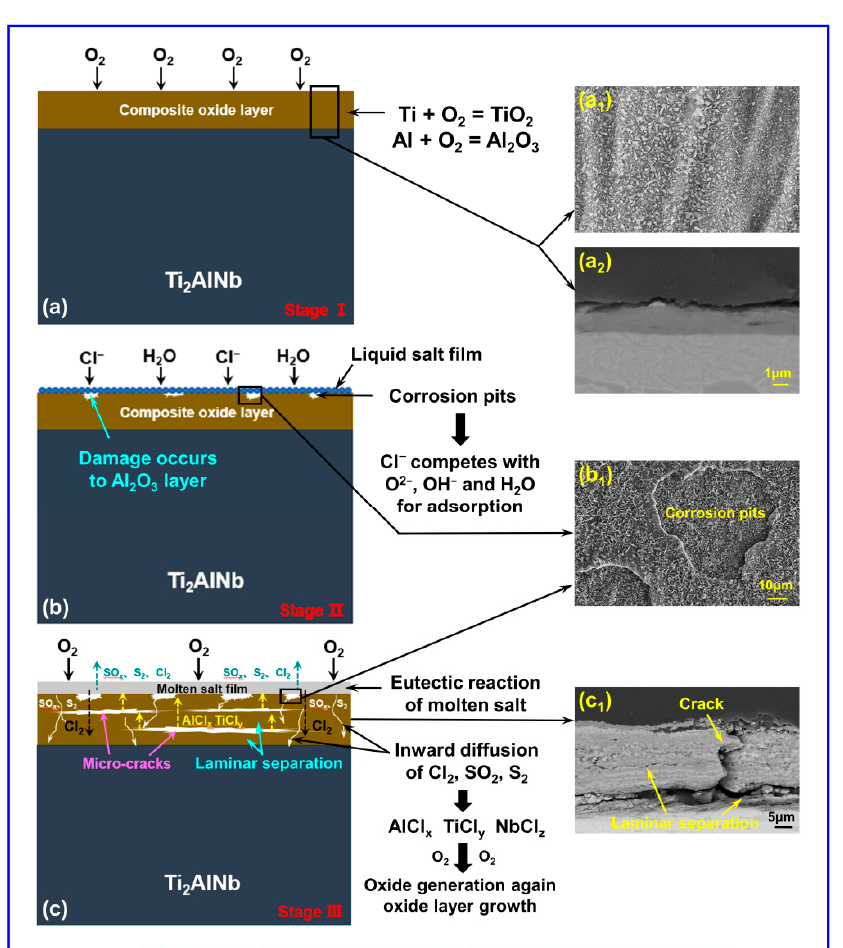
Figure 9. Corrosion degradation mechanisms in alternating high temperature-salt spray test: ( a – c ) Mechanistic diagram of the test procedure; ( a1 , a2 ) Microstructure of the alloy after oxidation test; ( b1 , c1 ) Microstructure of the alloy after alternating high temperature-salt spray